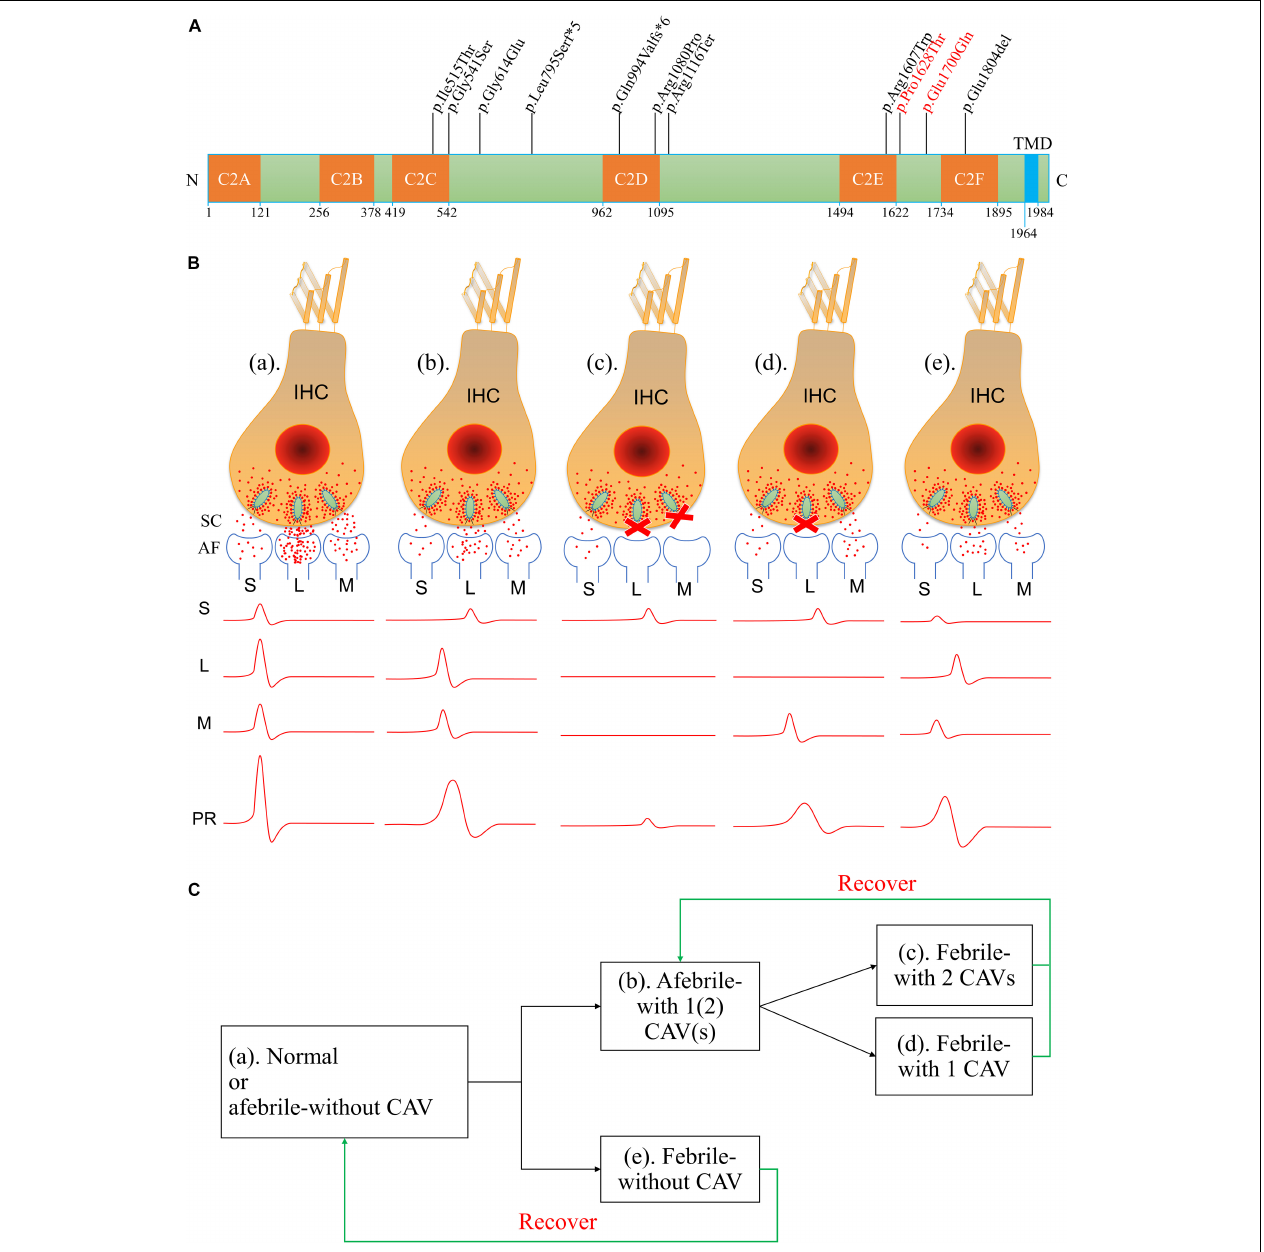
FIGURE 6 | Amino acid variants in otoferlin and possible mechanisms of otoferlin-dependent exocytosis in the inner hair cell (IHC) ribbon synapses of different temperature-sensitive auditory neuropathy (TSAN) patients. (A) Locations of otoferlin protein variants identified in TSAN patients. The numbers indicate the domain boundaries of otoferlin. The orange boxes indicate calcium-binding domains C2A through C2F, whereas the light-blue box indicates the transmembrane domain (TMD). Eleven variants have been found to be associated with TSAN, of which three variants (p.Gly614Glu, p.Glu1700Gln and p.Pro1628Thr) do not affect any otoferlin C2 domain. Two variants identified in this study (p.Glu1700Gln and p.Pro1628Thr) are shown in red. (B) Abnormal neural representation of sounds due to the dysfunction of synaptic transmission caused by OTOF variants in normal-hearing and TSAN patients. (a) Normal auditory function with normal synaptic transmission between IHCs and spiral ganglion neurons (SGNs). (b) TSAN patients with one or two C2 domain-affecting variants (CAVs) showed persistent partial dysfunction of all IHC–SGN synapses even when afebrile. (c) TSAN patients with two CAVs in a febrile state. Synaptic transmitter release was transiently blocked in almost all IHC–SGN synapses in addition to the more seriously affected remaining impaired synapses than those in panel (b) . (d) TSAN patients with only one CAV in a febrile state. A large number of IHC–SGN synapses temporarily failed to function. In addition, the remaining impaired synapses were more heavily affected in this state than in panel (b) . (e) TSAN patients with no CAVs in a febrile state. The IHC–SGN synapses were slightly affected but less severely affected than those of patients with one or two CAVs. The red dots represent glutamate (neurotransmitter), and the letters “S,” “L,” and “M” indicate small, large, and medium numbers, respectively, of IHC–SGN synapses. SC, synaptic cleft; AF, afferent fiber; PR, potential recording. (C) The genotype–phenotype relationships between OTOF variants and TSAN in patients with variable auditory function in this study and previous studies.